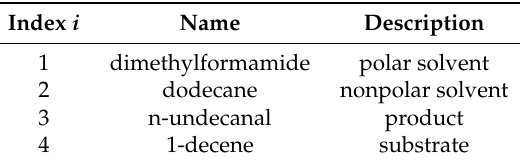
Table 1. Component